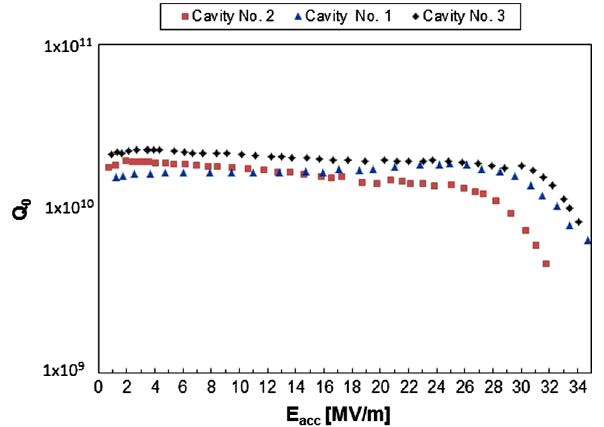
FIG. 30. Hydroforming of cells can be done by three cells simultaneously as well as cell by cell.